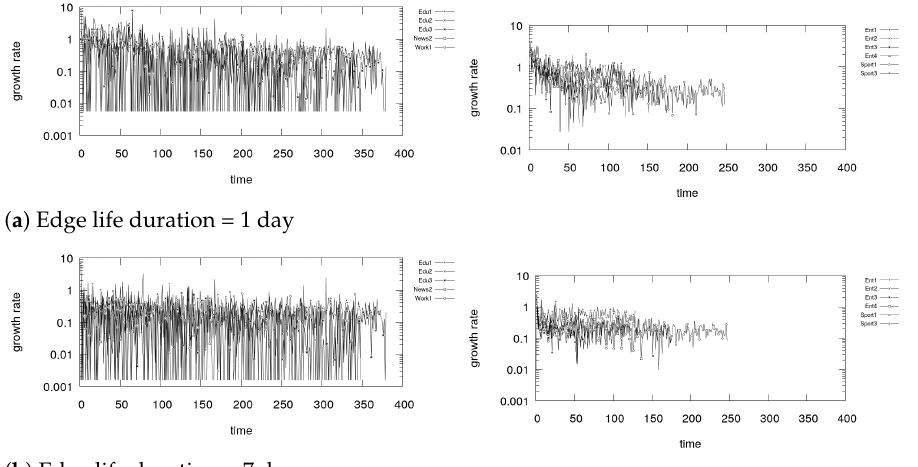
Figure 21. Growth rate of communities detected by